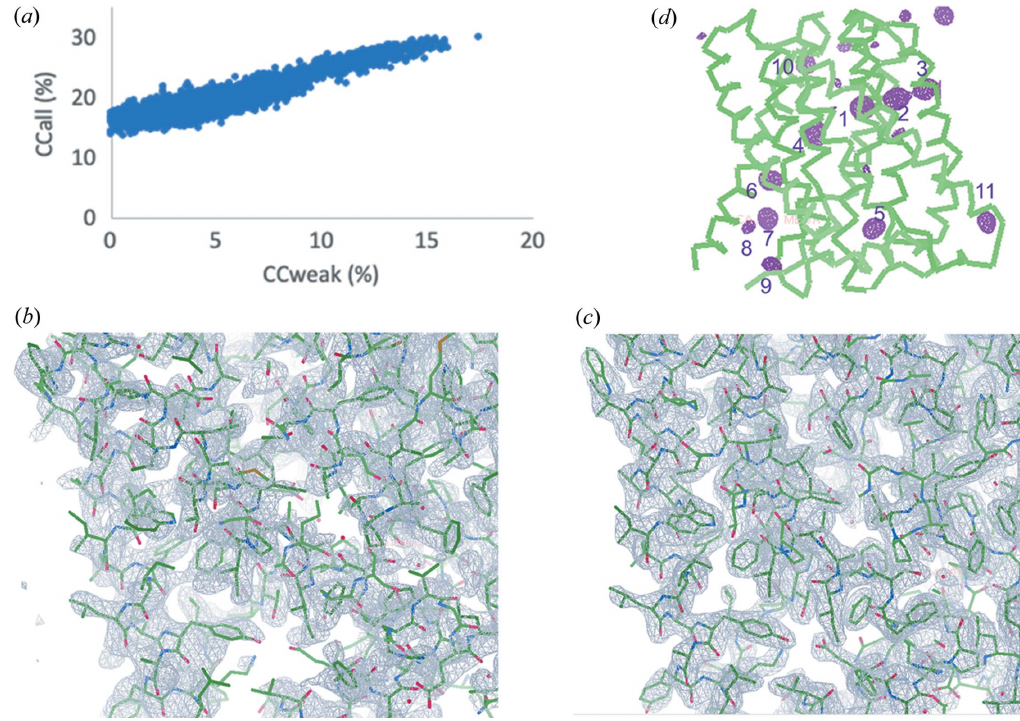
Figure 5 Structure determination for TehA. ( a ) CC all /CC weak of SHELXD trials. ( b ) Experimental electron density after density modification. ( c ) Refined electron-density map. ( d ) Bijvoet-difference Fourier peaks. Peaks for anomalous scatters are shown as magenta isomeshes contoured at 4 (cid:3) . The numbers indicate the positions of anomalous scatters in the structure: 1–9, sulfur from protein; 1, M91; 2, Cys211; 3, M174; 4, M267; 5, M201; 6, M294; 7, M58; 8, M301. Peaks 9–11 are not from protein sulfur atoms. The overall structure model of the TehA protomer from native-SAD is shown as